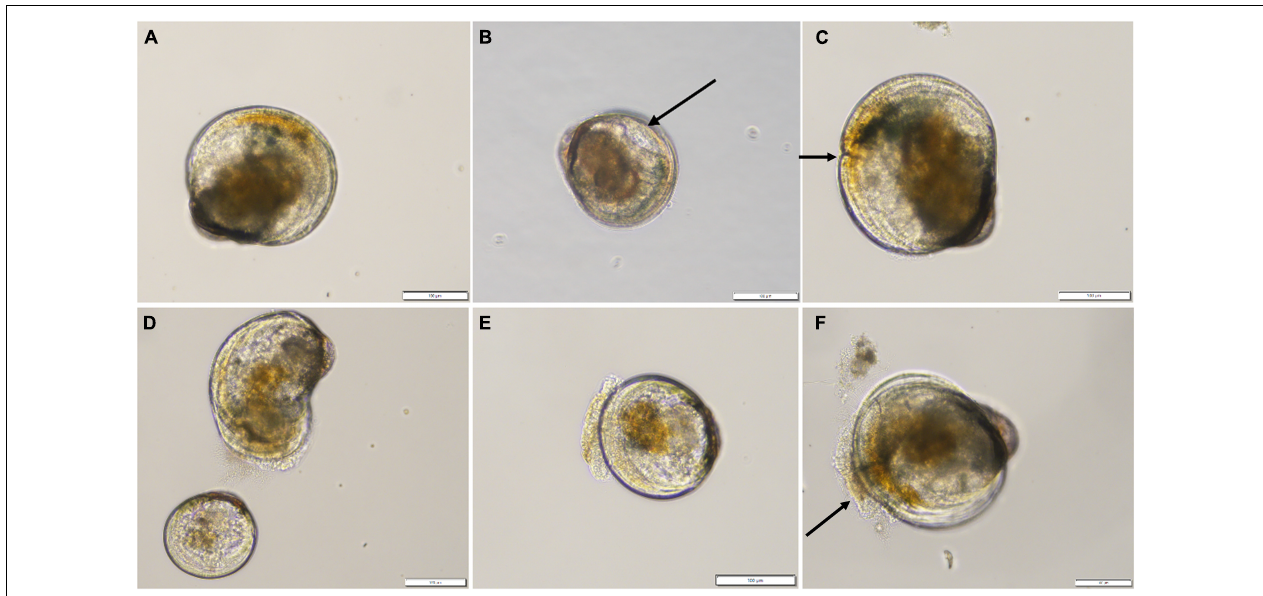
FIGURE 2 | Examples of normal (A) and abnormal (B–F) Crassostrea gigas larvae observed in the “Stressed low” and “Stressed high” treatments after 96 h. Anomalies consisted of indented mantle (arrow, B ), indented shell margin (arrow, C ), severe shell deformity ( D top), pale non-feeding larvae (D) , protruded velum (E) , or abnormal presence of bacteria on velum (arrow, F ). Scale bar: 100 µ